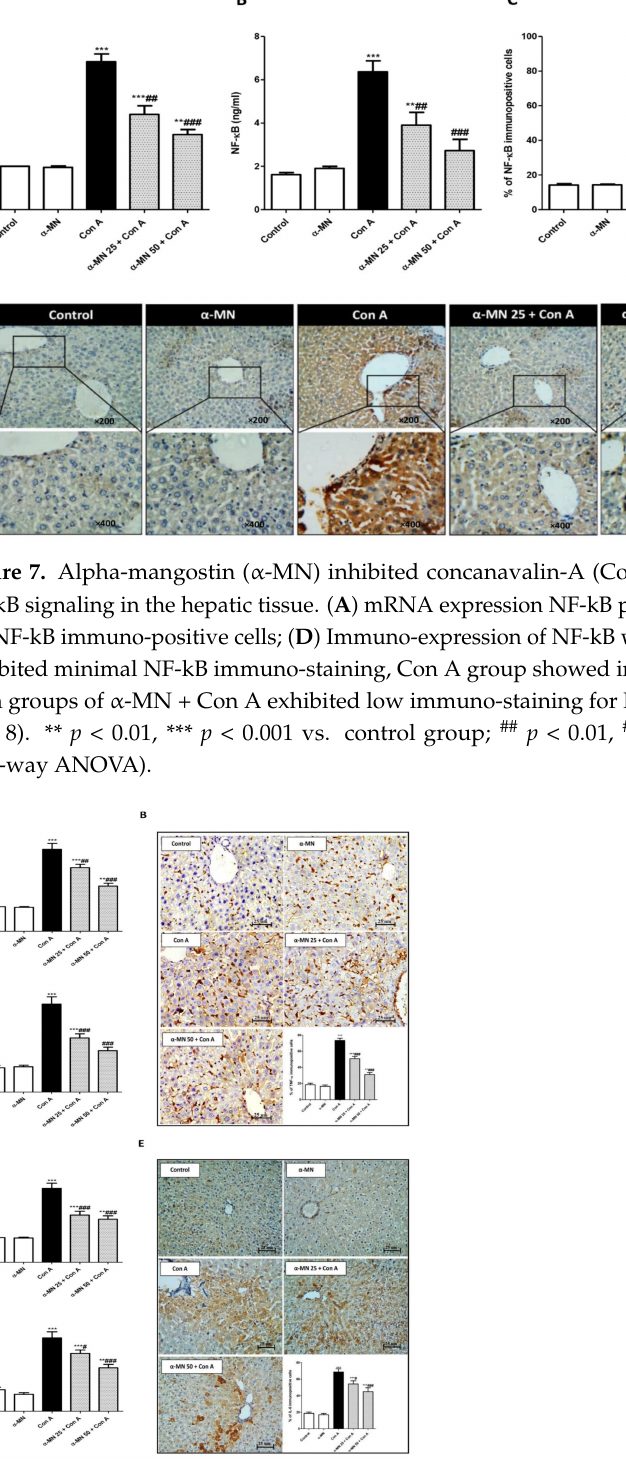
Figure 8. Alpha-mangostin ( α -MN) decreased concanavalin-A (Con A)-induced enhancement of the TNF- α /IL-6 signaling in the hepatic tissue. ( A ) mRNA expression of TNF- α ; ( B ) Immuno-expression of TNF- α ( × 400); ( C ) Level of TNF- α ; ( D ) mRNA expression of IL-6; ( E ) Immuno-expression of IL-6 ( × 400); ( F ) Level of IL-6. The immuno-expression of TNF- α and IL-6 was minimal in α -MN pretreated groups compared to intense staining in the Con A group. Data are the mean ± SE. ( n = 8). ** p < 0.01, *** p < 0.001 vs. control group; # p < 0.05, ## p < 0.01, ### p < 0.001 vs. Con A group (one-way